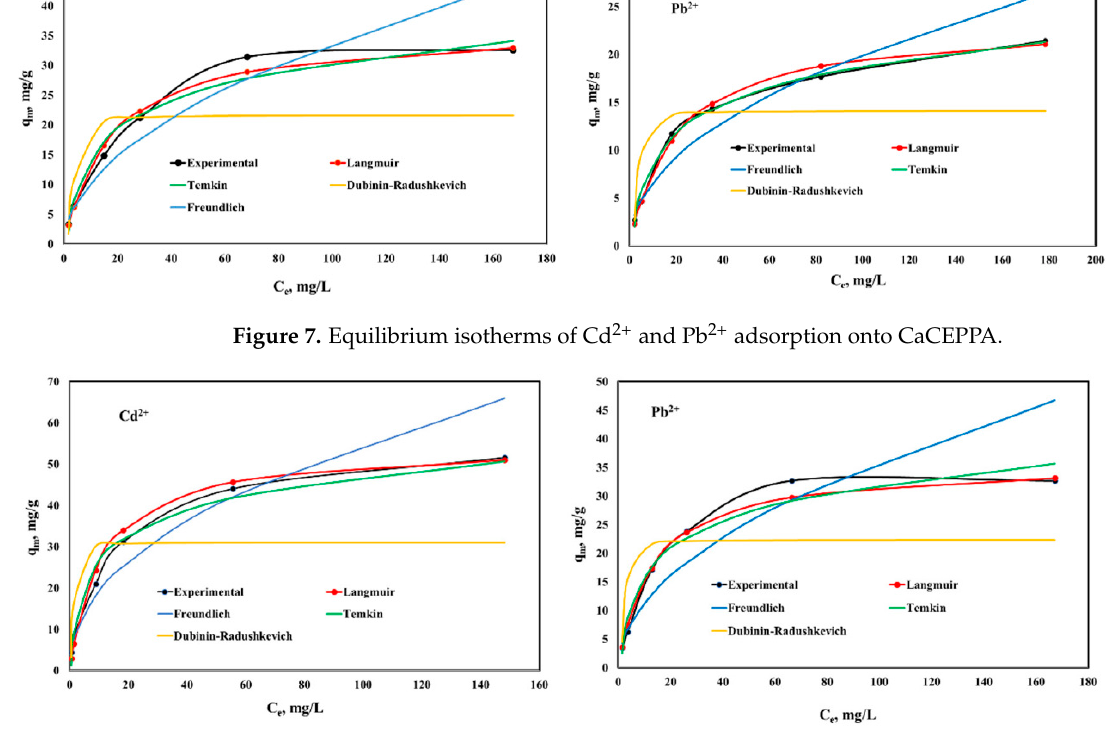
Figure 8. Equilibrium isotherms of Cd 2+ and Pb 2+ adsorption onto CoCEPPA.